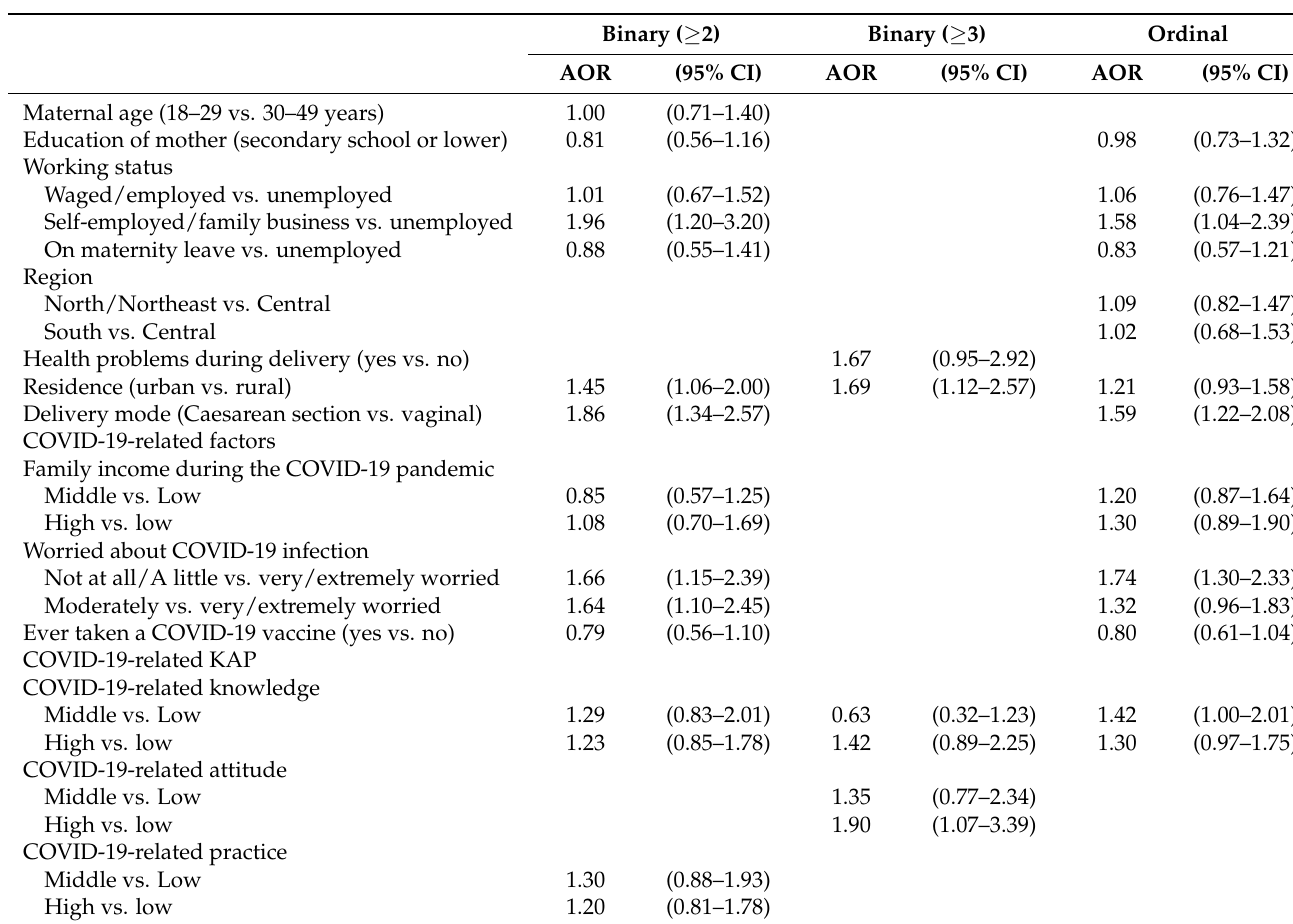
Table 3. Multivariate binary and ordinal logistic regression analyses of associations between selected factors and postnatal care